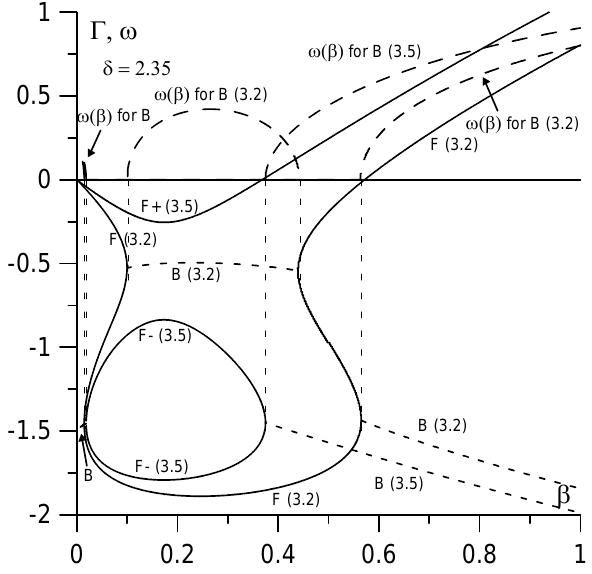
Fig. 8b. Growth rate spectrum for δ = 2 . 35 (dawn/dusk). Note that flute modes F+ (3.5) and F (3.2) become unstable exactly when the ballooning modes B (3.5) and B (3.2) split. Figure 8b. Growth rate spectrum for 35.2 =δ (dawn/dusk). Note that flute modes F+ (3.5) of the equilibrium processes. For this reason, we should con- and F (3.2) become unstable exactly when ballooning modes B (3.5) and B (3.2) split. sider the coupling point to be the practical stability